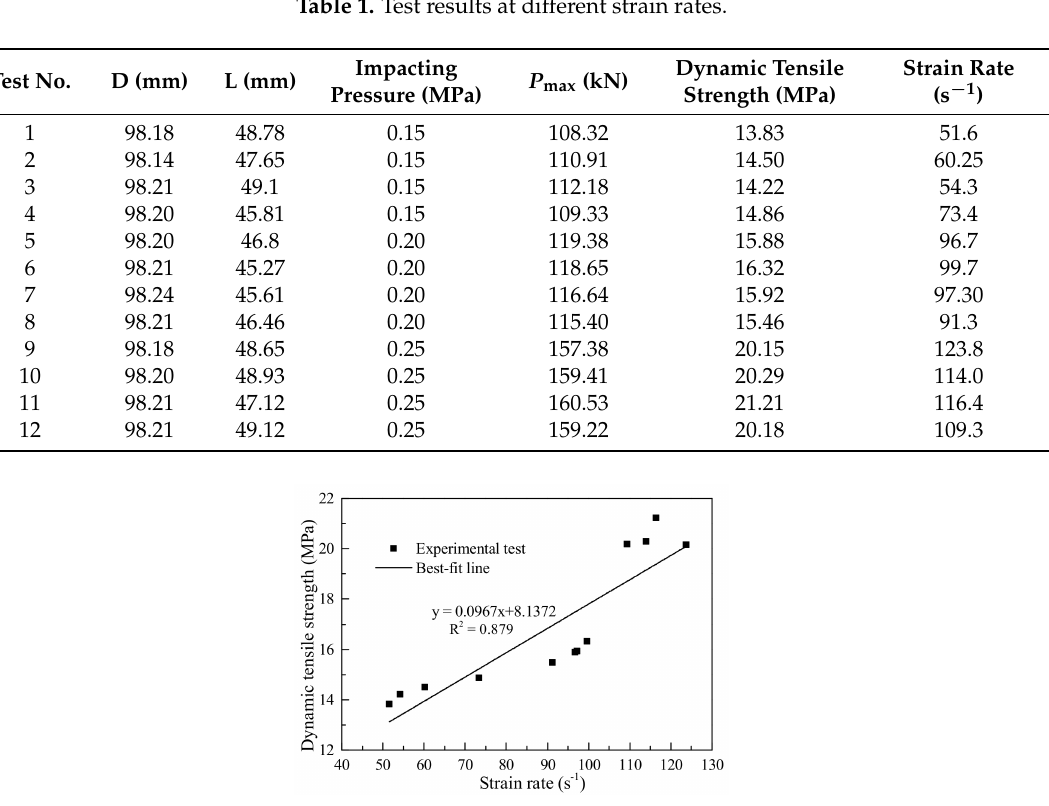
Table 1. Test results at different strain rates.